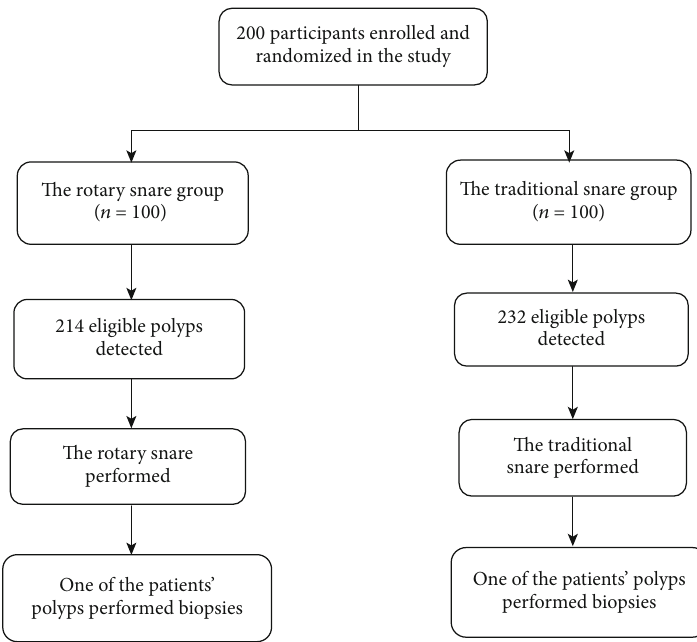
Figure 1: The fl ow chart of the whole process of this